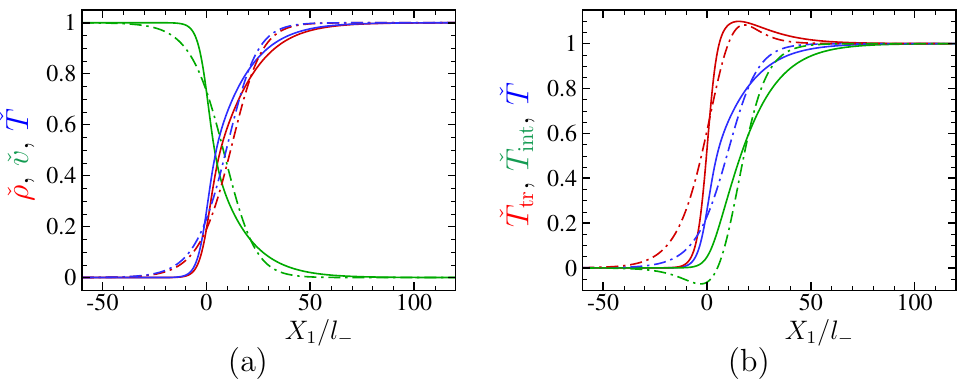
Figure 2. Profiles of ˇ ρ , ˇ v , ˇ T , ˇ T tr , and ˇ T int in the case of the pseudo-CO 2 gas at M − = 1.3 for µ b / µ = 10. ( a ) ˇ ρ , ˇ v , and ˇ T ; ( b ) ˇ T tr , ˇ T int , and ˇ T . The solid line indicates the result based on the two-temperature NS equations (18), and the dot-dashed line that based on the ordinary NS equations (14). The red, green, and blue lines indicate, respectively, ˇ ρ , ˇ v , and ˇ T in panel ( a ) and ˇ T tr , ˇ T int , and ˇ T in panel ( b ).